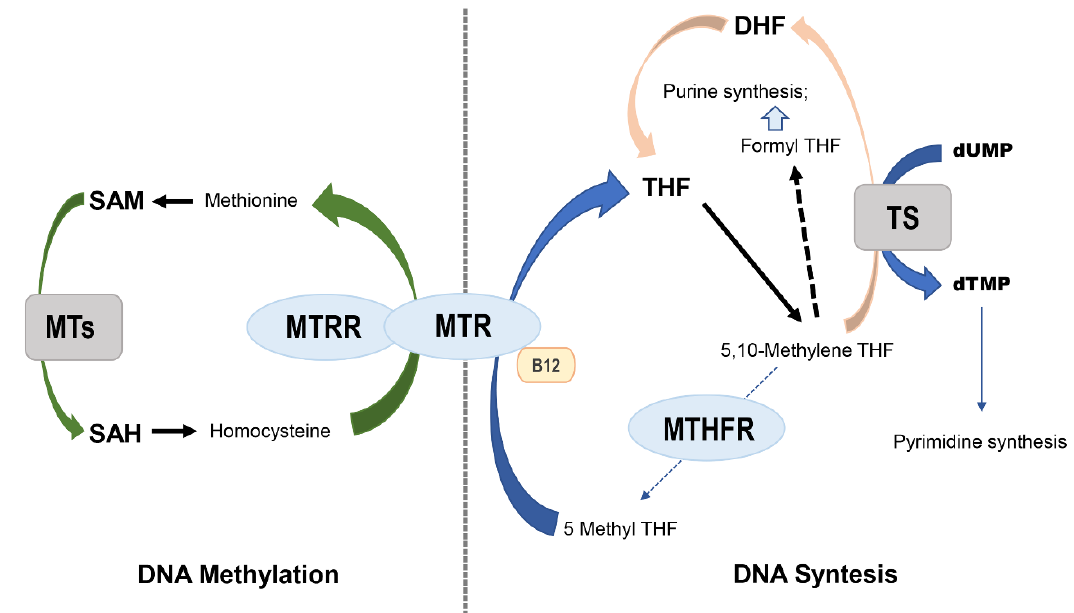
Figure 1. Schematic of folate metabolism. Effects of reduced MTHFR activity on DNA synthesis and methylation. DHF, di- hydrofolate; MTs, methyltransferases; THF, tetrahydrofolate; SAM, S-adenosyl methionine; SAH, S-adenosyl homocysteine; TS, thymidylate synthase. MTR, methionine synthase; MTRR, methionine synthase